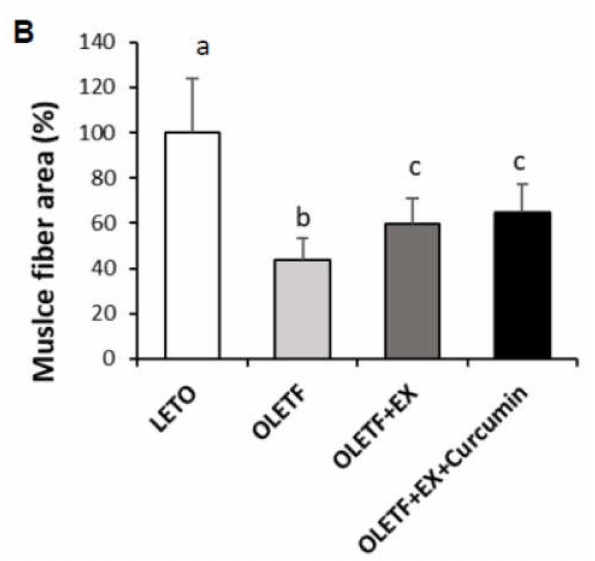
Figure 2. Curcumin reduced diabetic-related phenotypes of liver, muscle, skin and small intestine in diabetes rats. ( A ) Representative hematoxylin and eosin (H&E) staining of liver, muscle, skin, and small intestine tissues of OLETF and LETO controls obtained at the end of the eight weeks experimental period. Exercise plus curcumin changed the morphologies of liver, muscle layers in skin (arrowed) and villi in small intestine (arrowed). ( B ) The quantitate data of muscle fiber size in experimental rats. The cross-sectional area of the muscle fiber was measured for all muscle fibers of five images selected from each animal. In data, the average area of muscle fibers was calculated and presented as the mean area value of total muscle fibers in five images. Significant di ff erences were determined using one-way ANOVA followed by Turkey’s post-hoc test. Di ff erent superscripts indicate significant di ff erence ( p < 0.05). LETO controls: age-matched control group, OLETF controls: diabetic group, OLETF + EX: diabetic exercise-trained group, OLETF + EX + Curcumin: diabetic exercise-trained plus curcumin (5 g / kg in